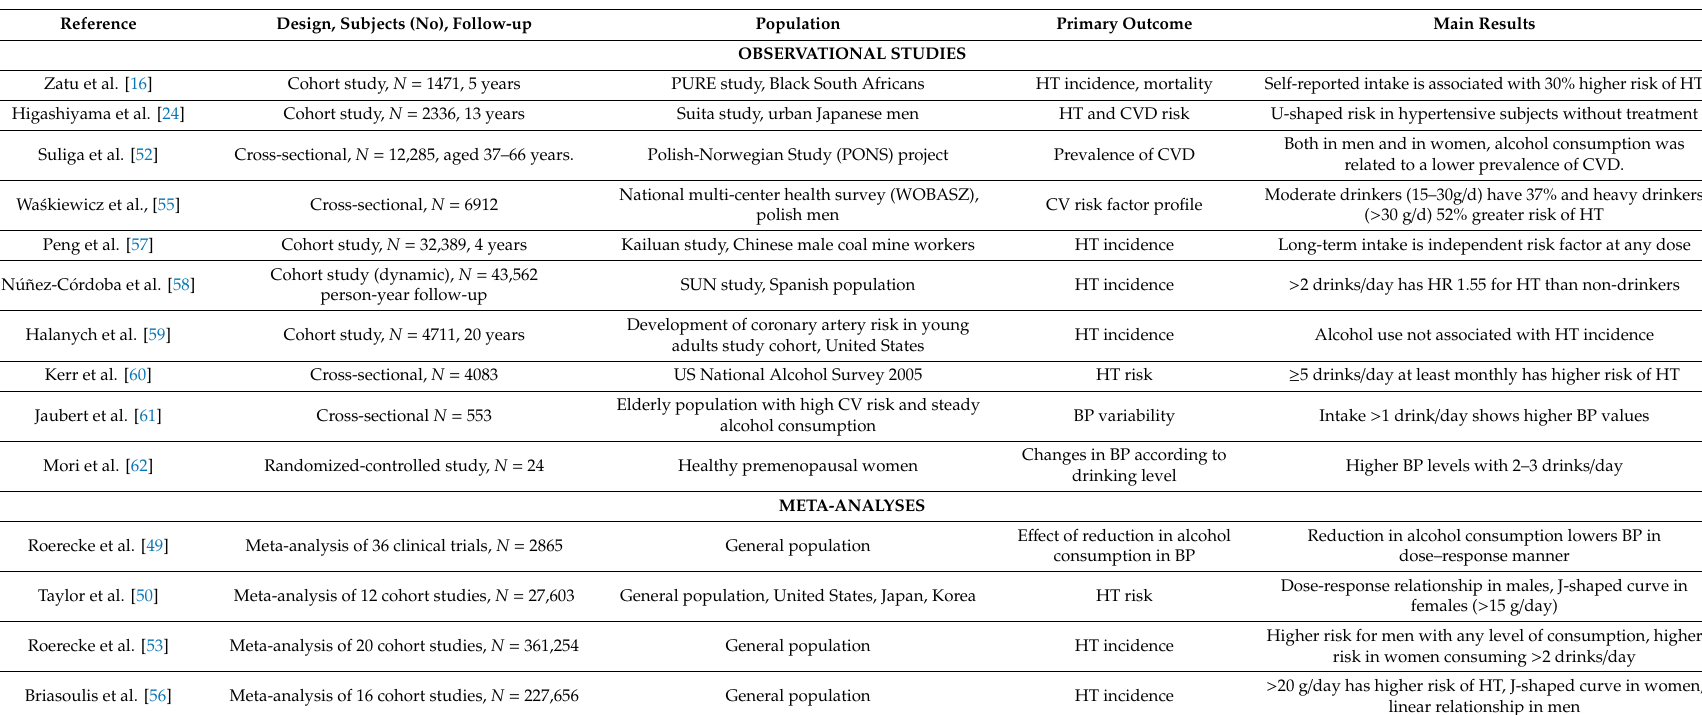
Table 2. Characteristics of 14 studies evaluating the e ff ect of alcohol on